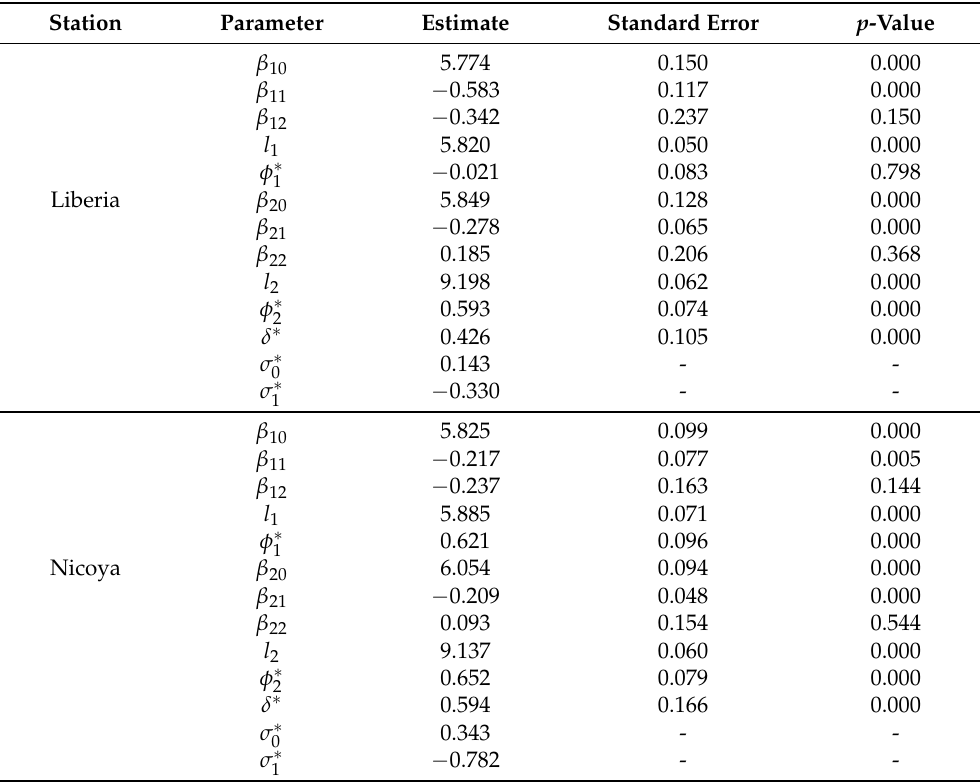
Table 1. Estimates and standard errors of the parameters of the double-Gaussian